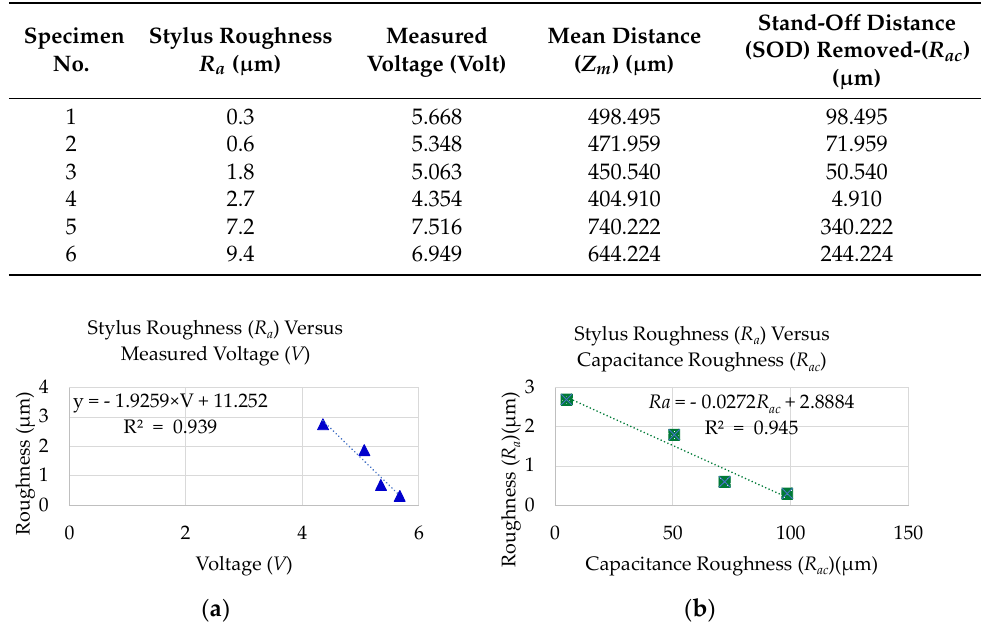
Figure 8 . Roughness prediction model using experiment for selected specimen: ( a ) regression model for stylus roughness ( R a ) versus voltage ( V ); ( b ) regression model for stylus roughness ( R a ) Versus capacitance roughness ( R ac ).